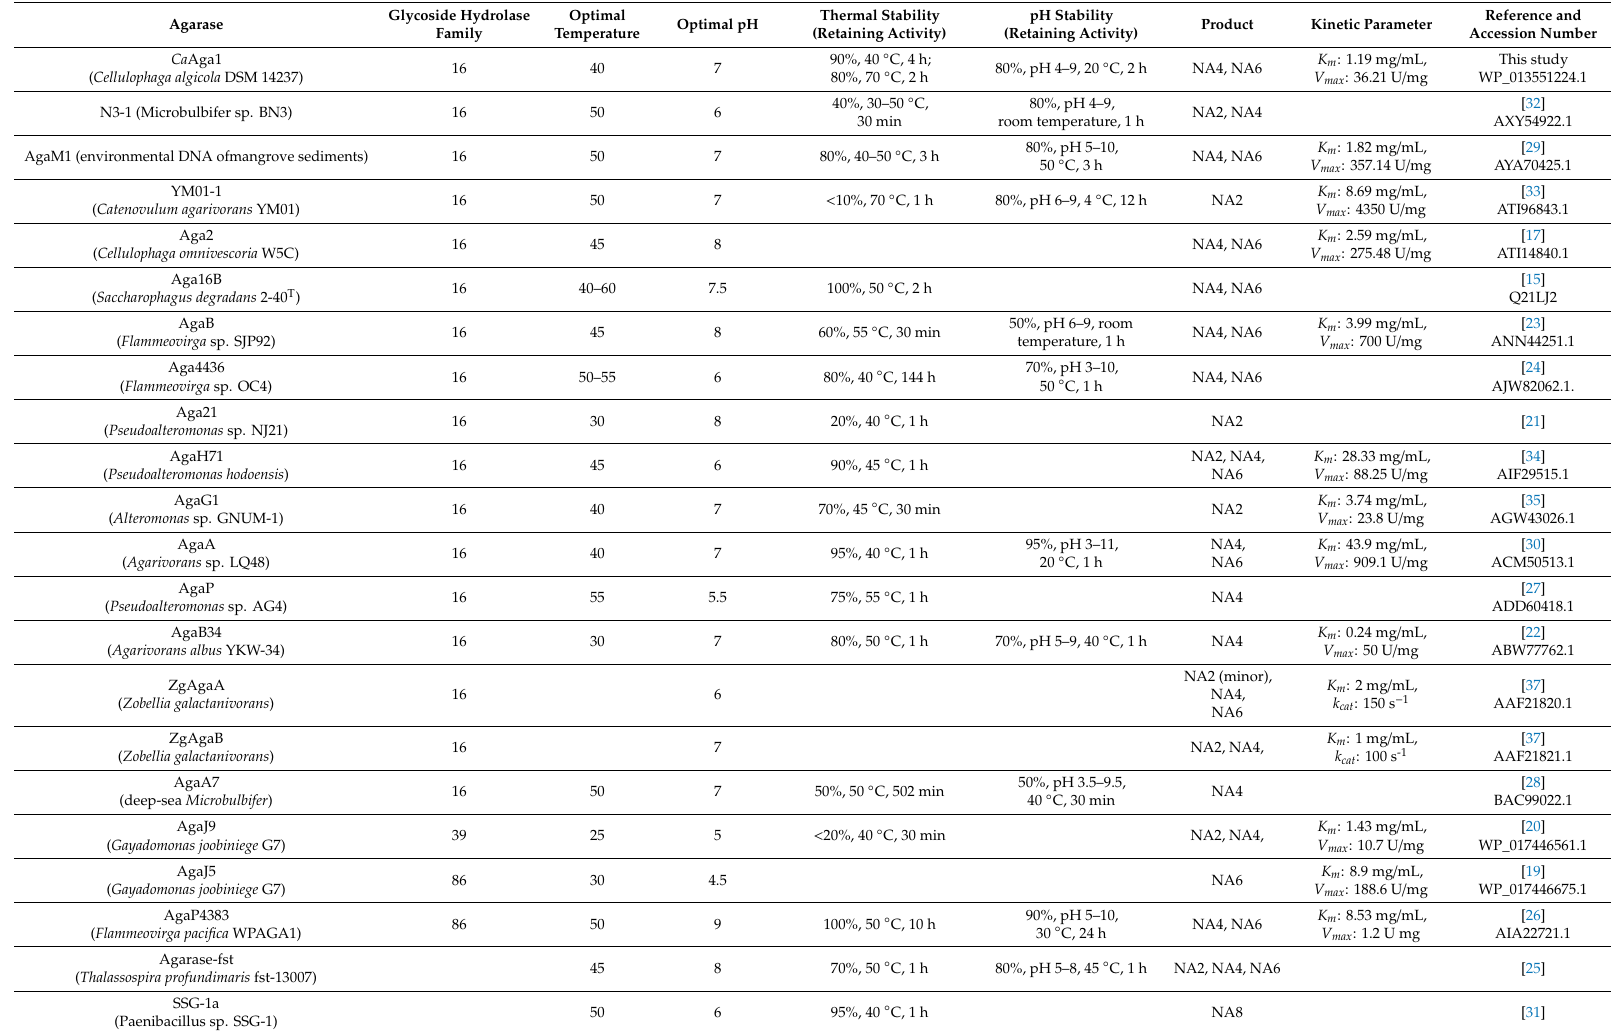
Table 1. Biochemical properties of characterized